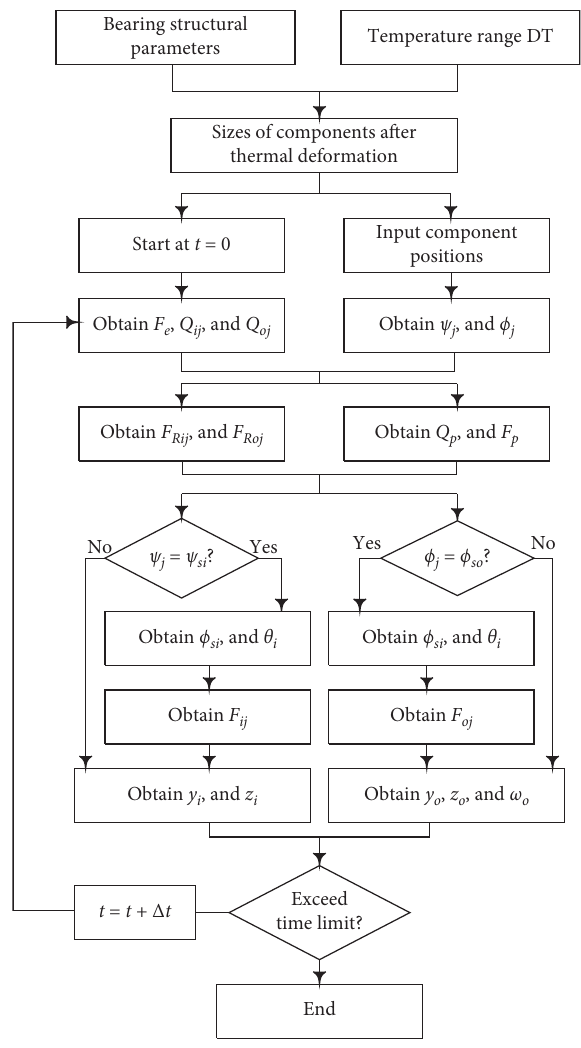
Figure 5: Calculation flowchart. Table 1: Parameters of ceramic ball bearings and the pedestal.